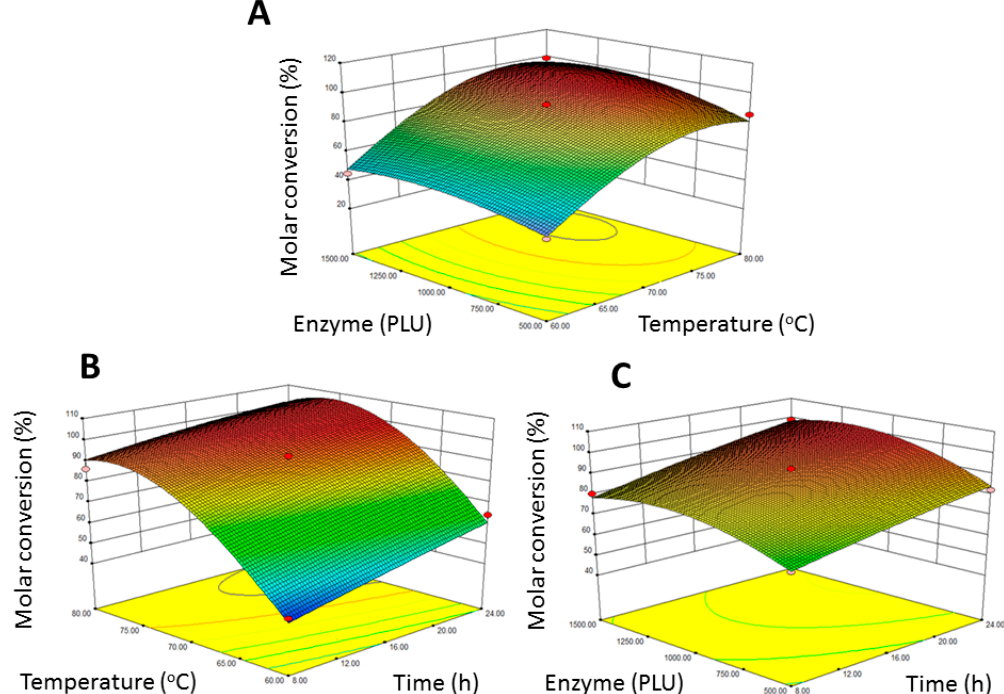
Figure 1. Response surface plot for the relationships between molar conversion and experimental variables. Response surface plot showing the relationships between molar conversion of 2-ethylhexyl ferulate and reaction parameters: ( A ) reaction temperature and enzyme amount; ( B ) reaction temperature and reaction time and ( C ) reaction time and enzyme amount.